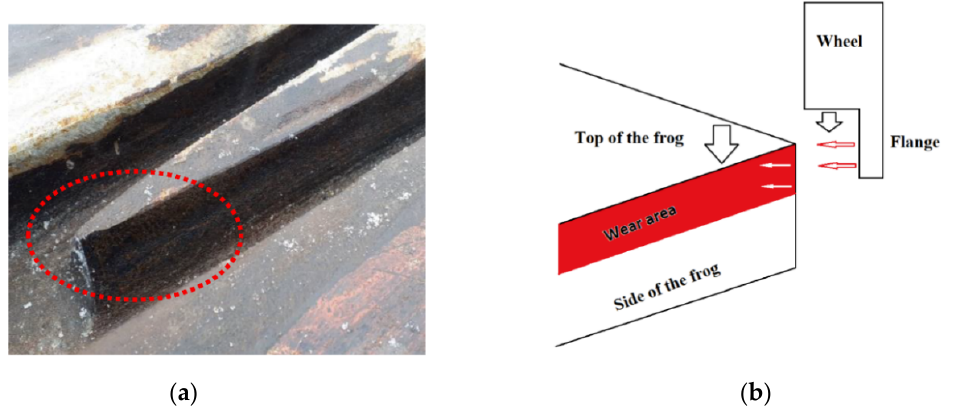
Figure 2. ( a ) The wear effects on the side of the frog in railway switches and crossings; ( b ) a schematic figure to describe the applied loading forces from the wheel and the wheel flange on the frog.